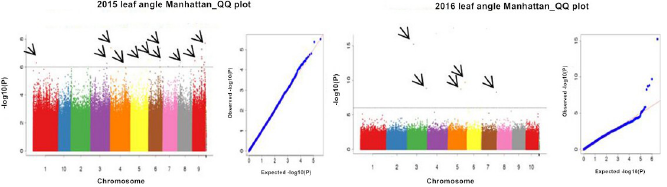
Fig 4. Leaf angle Manhattan plot and QQ plot for the two